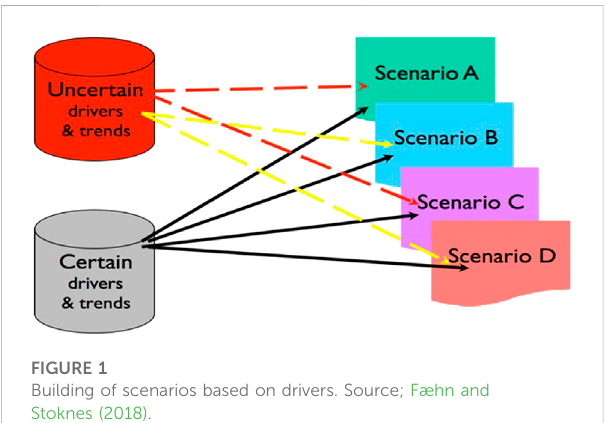
FIGURE 1 Building of scenarios based on drivers. Source; Fæhn and Stoknes (2018).